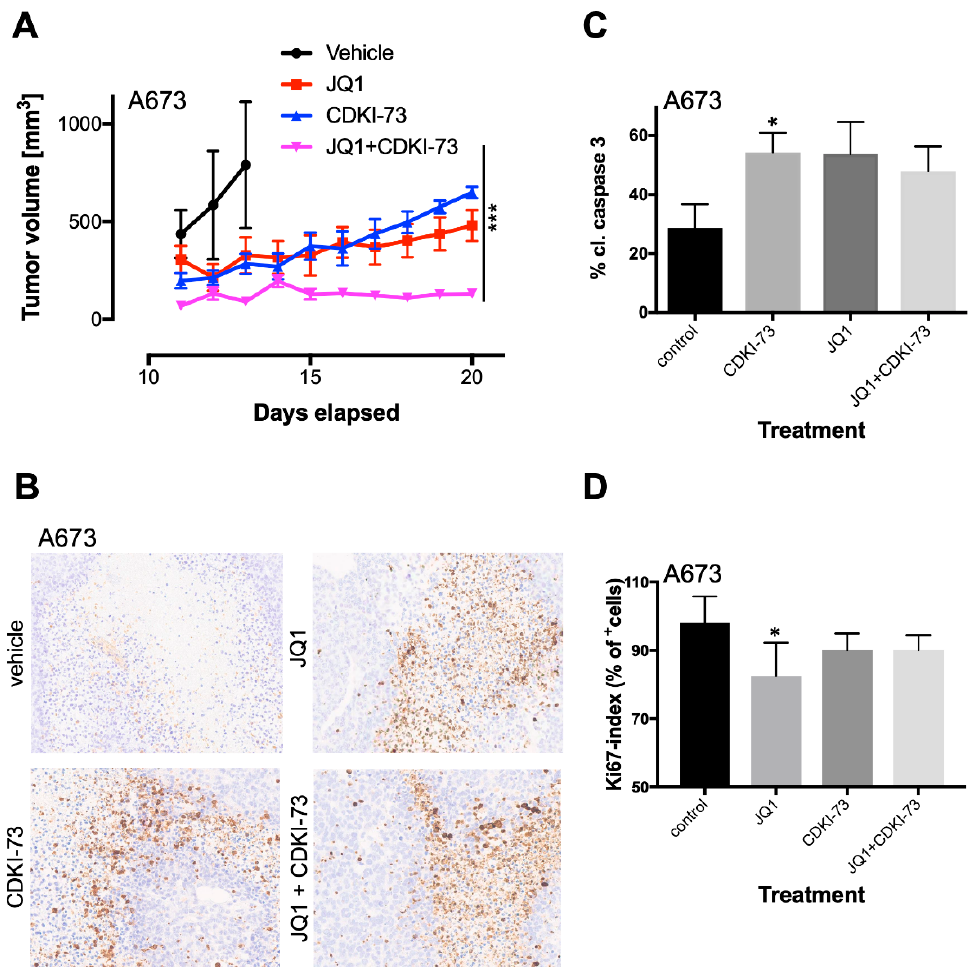
Figure 5. Combined targeting of CDK9 and BRD4 results in the inhibition of proliferation and tumor growth. ( A ) In vivo anti-tumor efficacy of JQ1 and CDKI-73 as a single agent or in combination against A673-bearing Rag2 − / − γ C − / − mice xenografts. A673 cells were injected subcutaneously (s.c.) into mice.